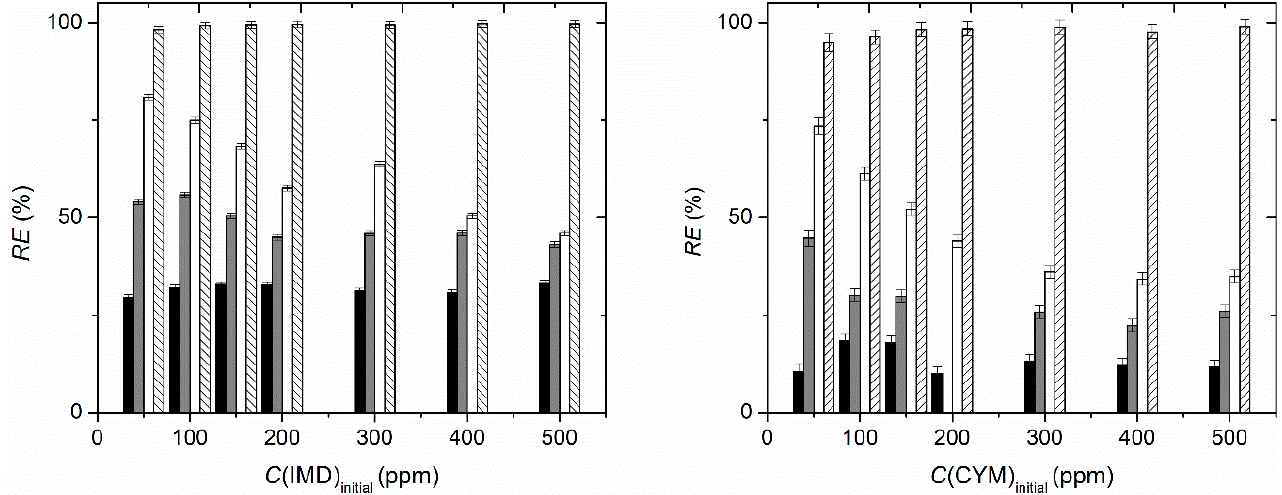
Figure 7. Removal efficiency ( RE% ) of IMD (left) and CYM (right) by different adsorbents: PCD (black columns), PCD/AC 5% (grey), PCD/AC 10% (white) and AC (lines).